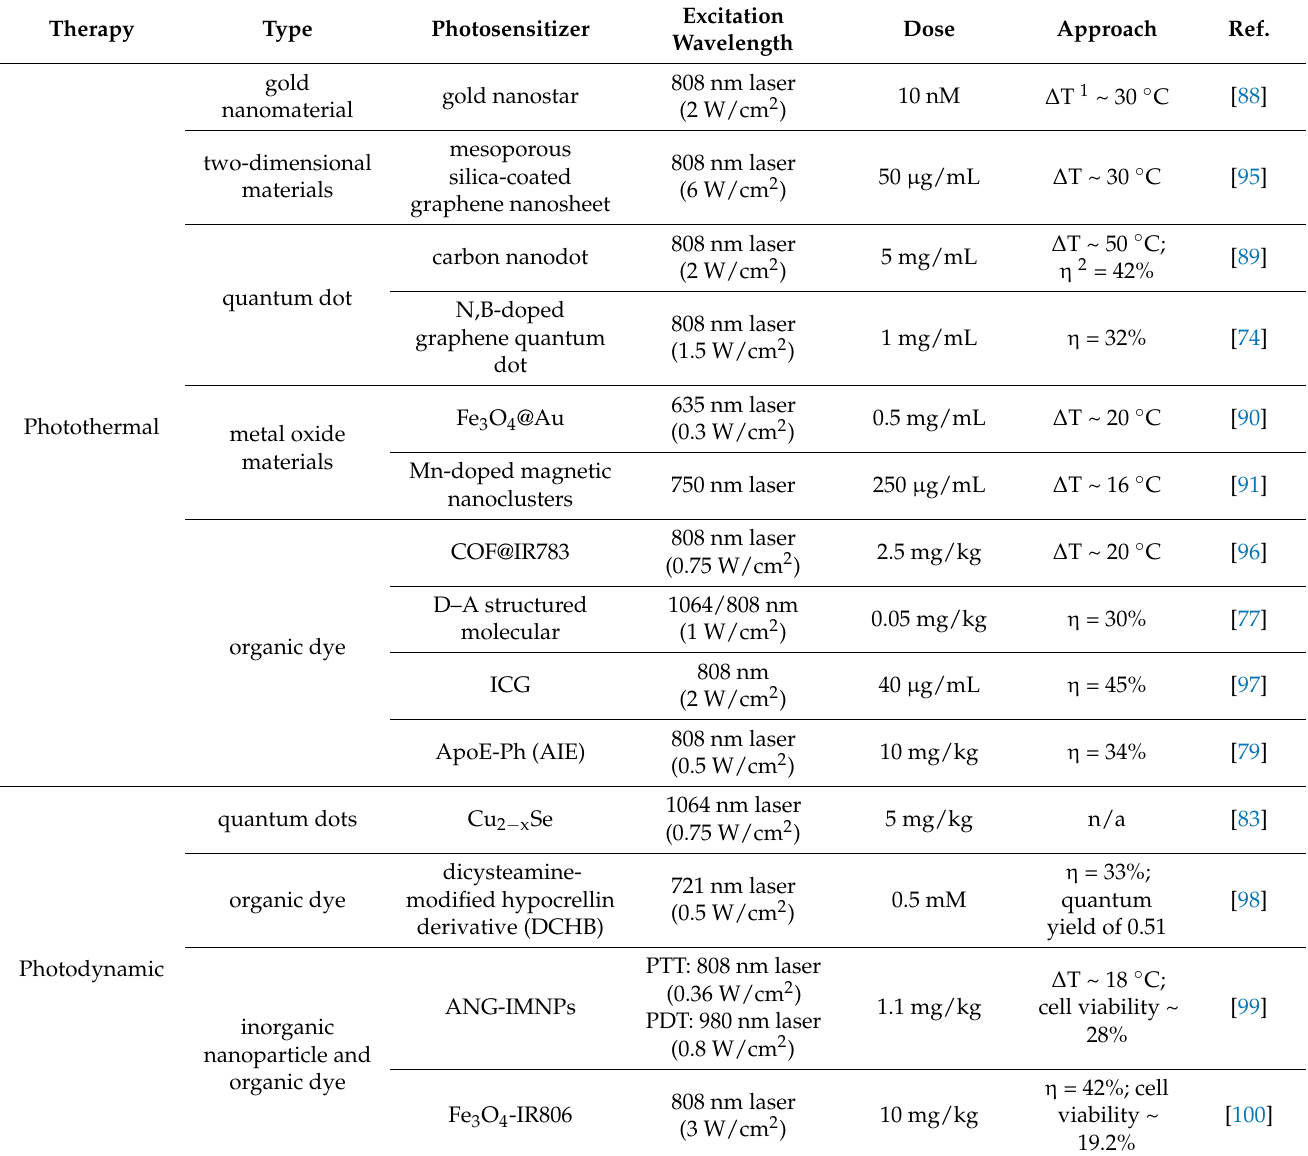
Table 2. The in vivo phototherapy with different